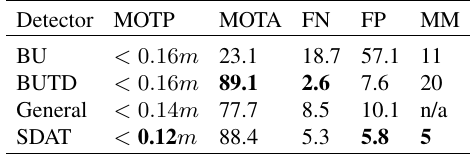
Figure 7: Pedestrian flow in a public place. Pedestrian trajectories are in random colors, and the background is in black. Table 2: Tracking methods comparison using the CLEAR MOT metrics. MOTA, FN, FP are in %. The best value of each indi- cator is in bold. BU and BUTD results are from Spinello et al. (2011), Genera result is from Kaestner et al. (2012).